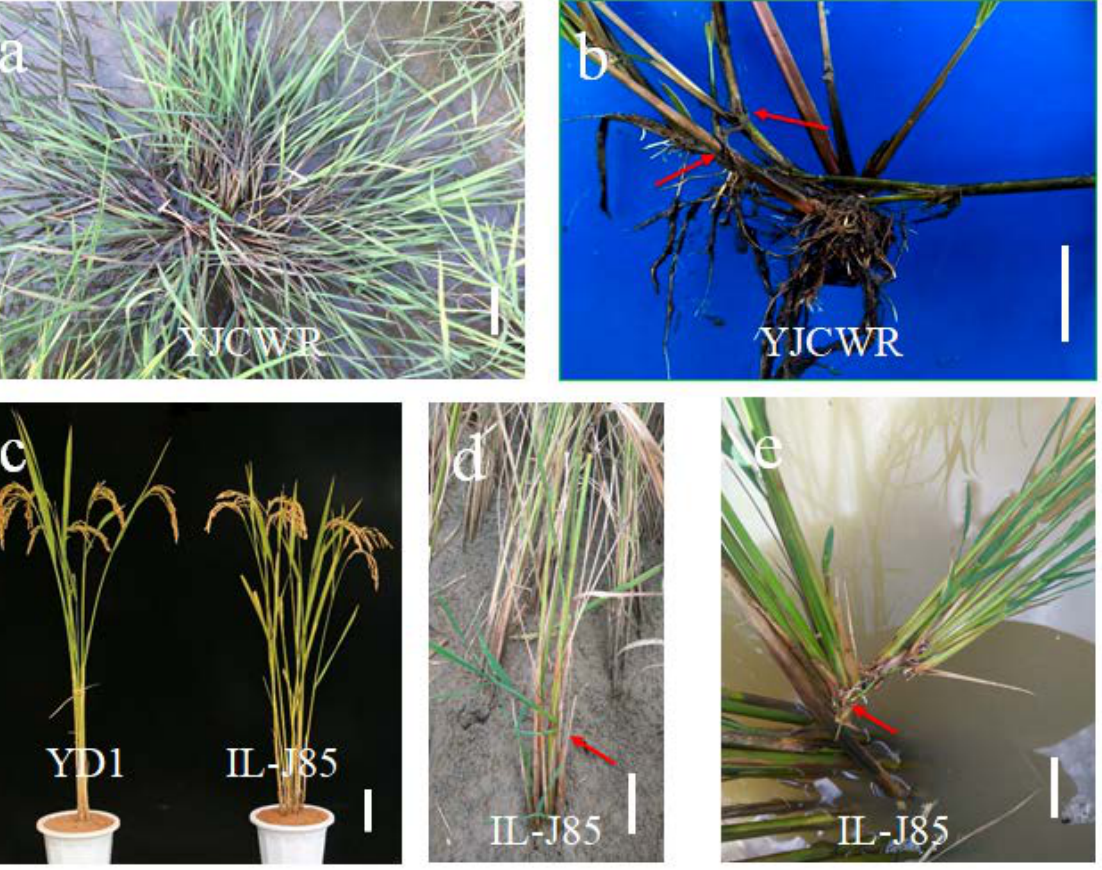
Figure 1. The phenotype of YJCWR, YD1, and IL-J85. ( a , b ) The phenotype of YJCWR. ( c ) YD1 and IL-J85 in the mature period. ( d ) IL-J85 15 days later after harvest. ( e ) IL-85 after crushing artificially or submerged naturally; the red arrow indicated the stem branches. Bar = 10